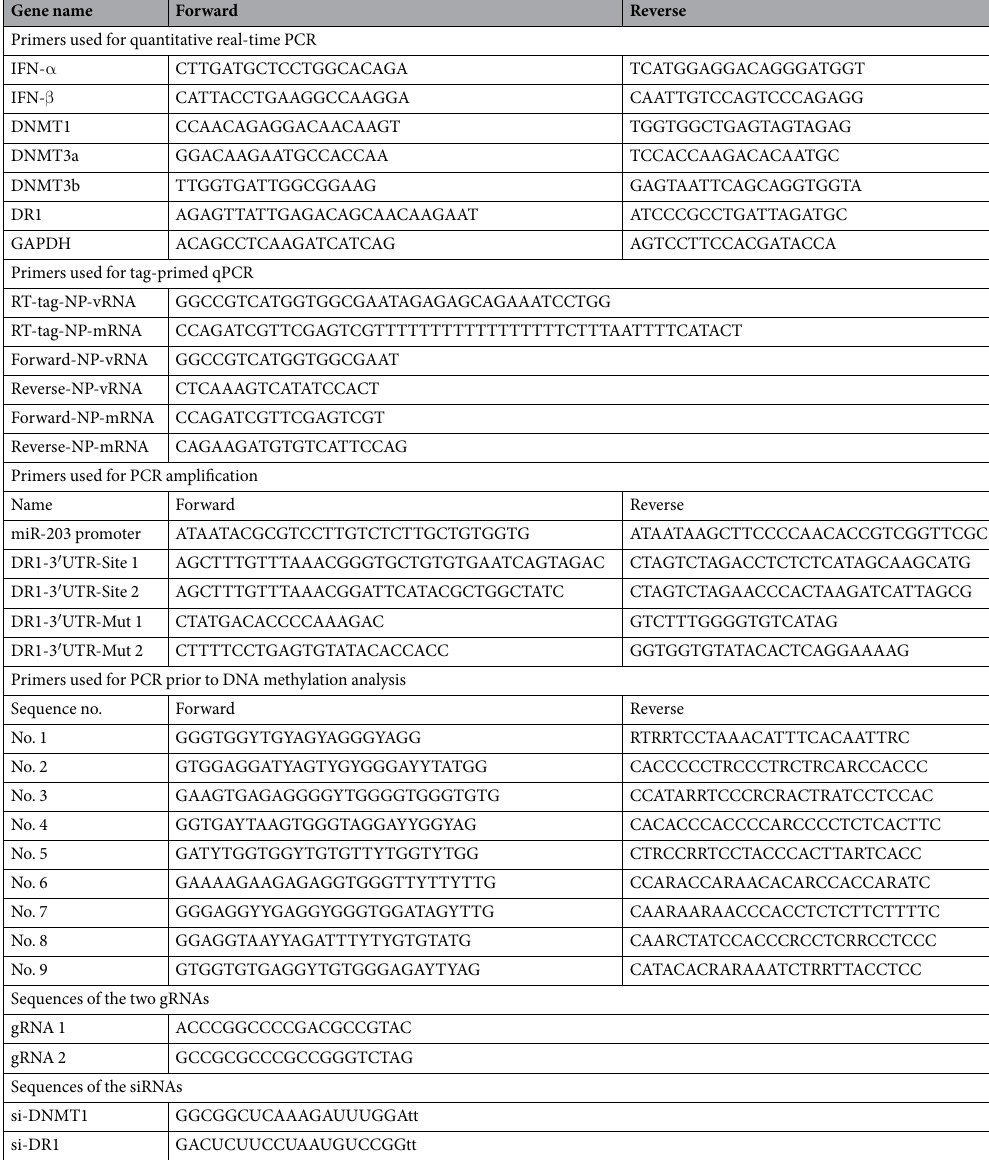
Table 1. Sequences of primers and siRNAs used in the